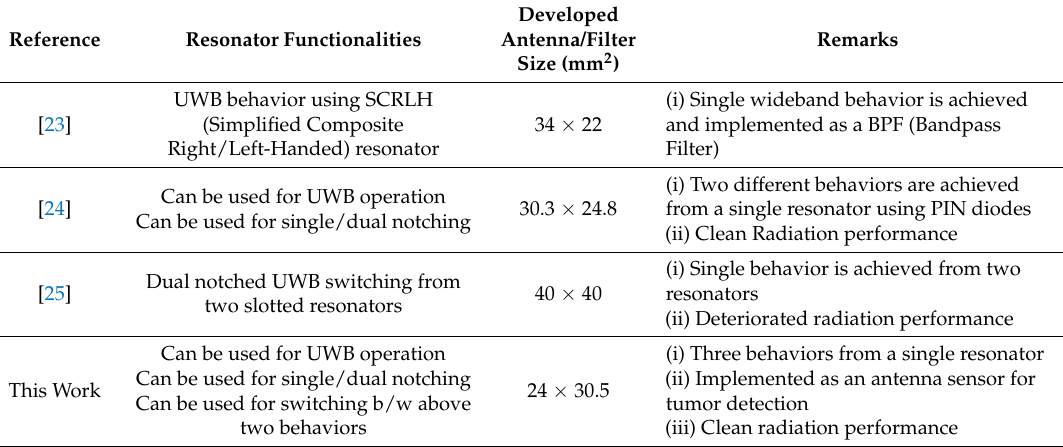
Table 3. Performance comparison of the proposed technique with other reported techniques.